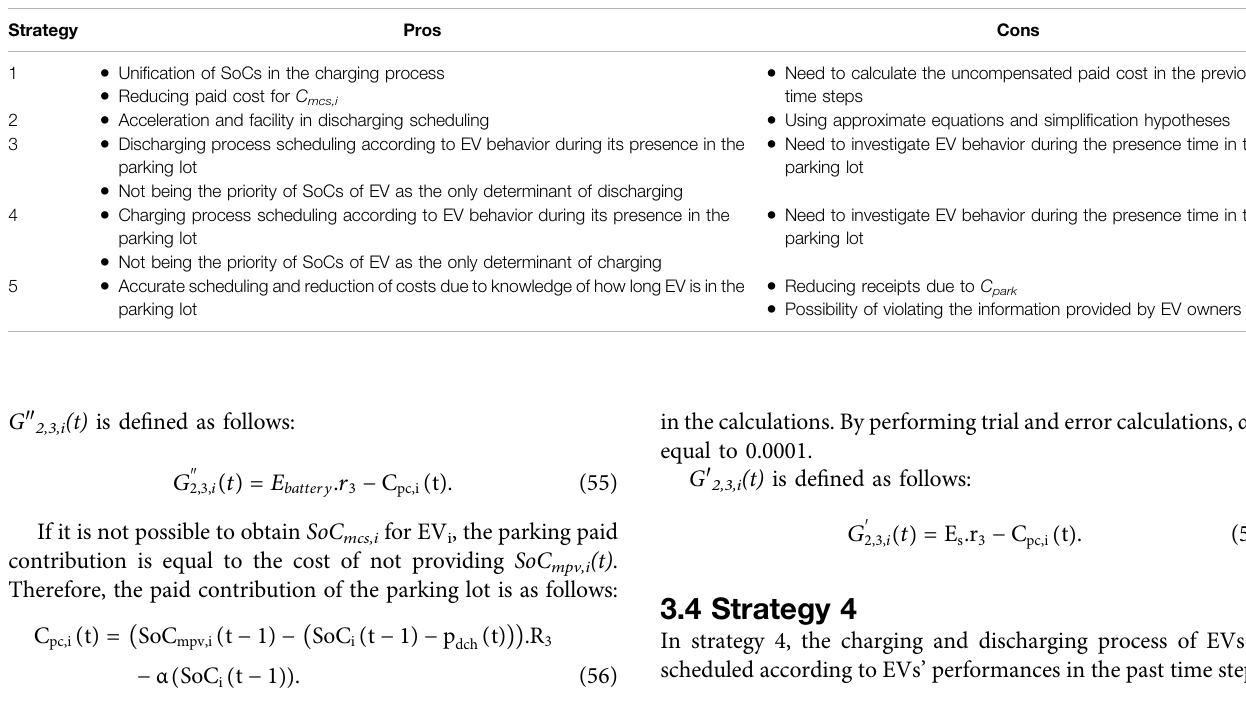
Frontiers in Energy Research |